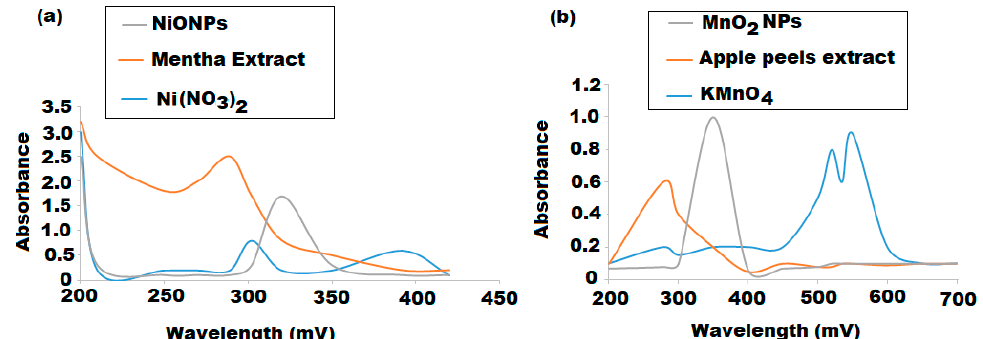
Figure 1. UV-Vis absorption spectra of synthesized ( a ) NiONPs and ( b ) MnO 2 NPs using Mentha spicata leaves and Malus domestica peel extracts, respectively.